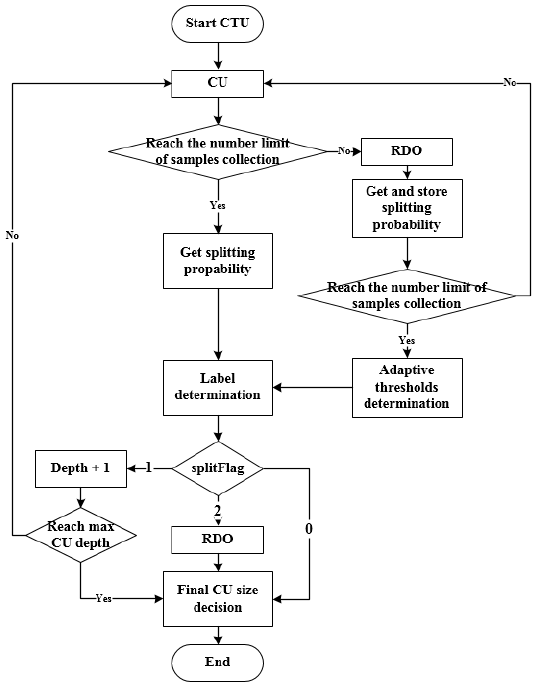
Figure 4. Flowchart of the proposed BTFA. Value 0 of splitFlag represents a nonsplit decision of a CU, while the values 1 and 2 are split and RDO decision,